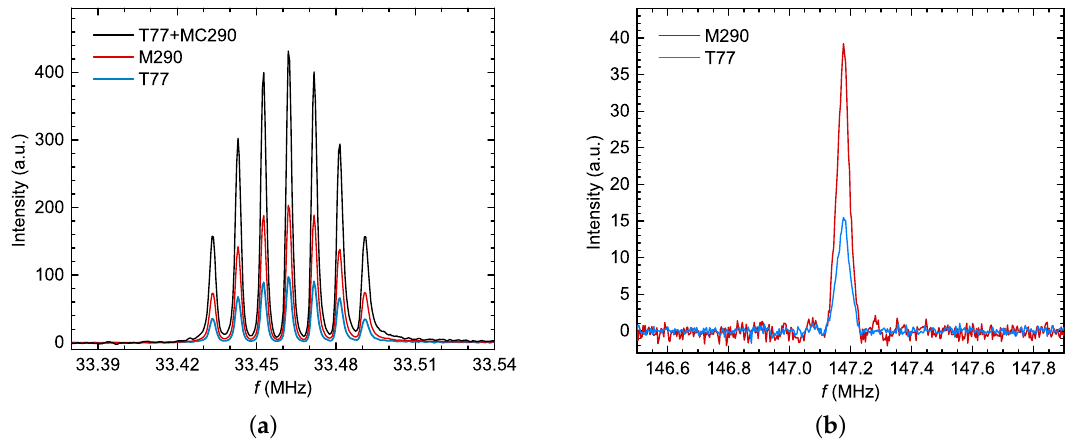
Figure 6. NMR spectra measured to check the validity of NMR receiving chain’s noise figure calculation: ( a ) 133 Cs in Cs 2 Cu 3 SnF 12 (the splitting of the spectra due to quadrupolar splitting into 7 lines is visible), ( b ) central line of 63 Cu in SeCuO 3 (quadrupolar satellites are too far apart to be excited by a single excitation